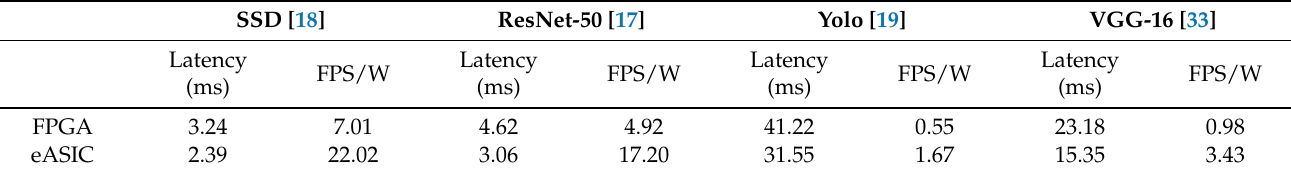
Table 5. Hardware performance comparison between the FPGA and eASIC design.